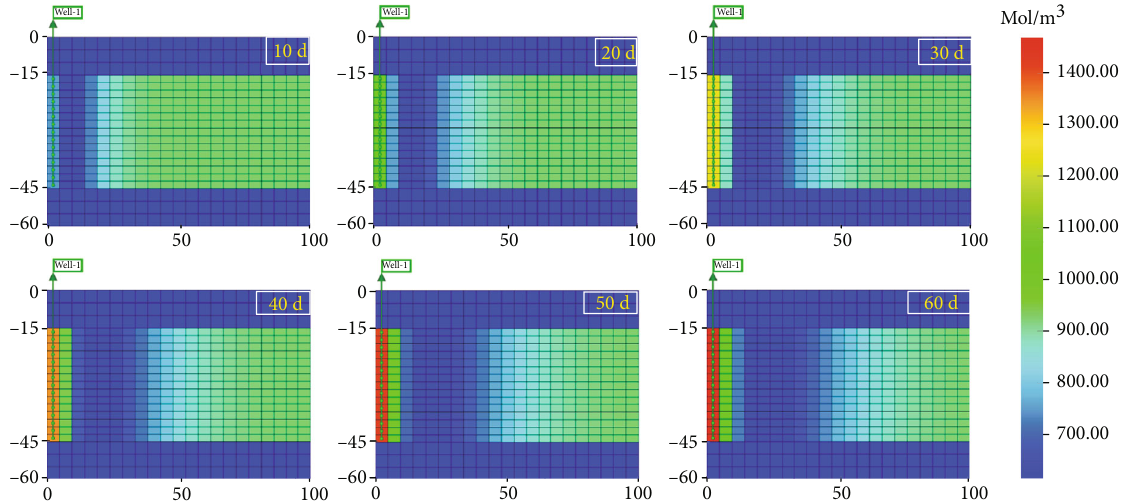
Figure 4: Evolution of spatial distribution of solid sand